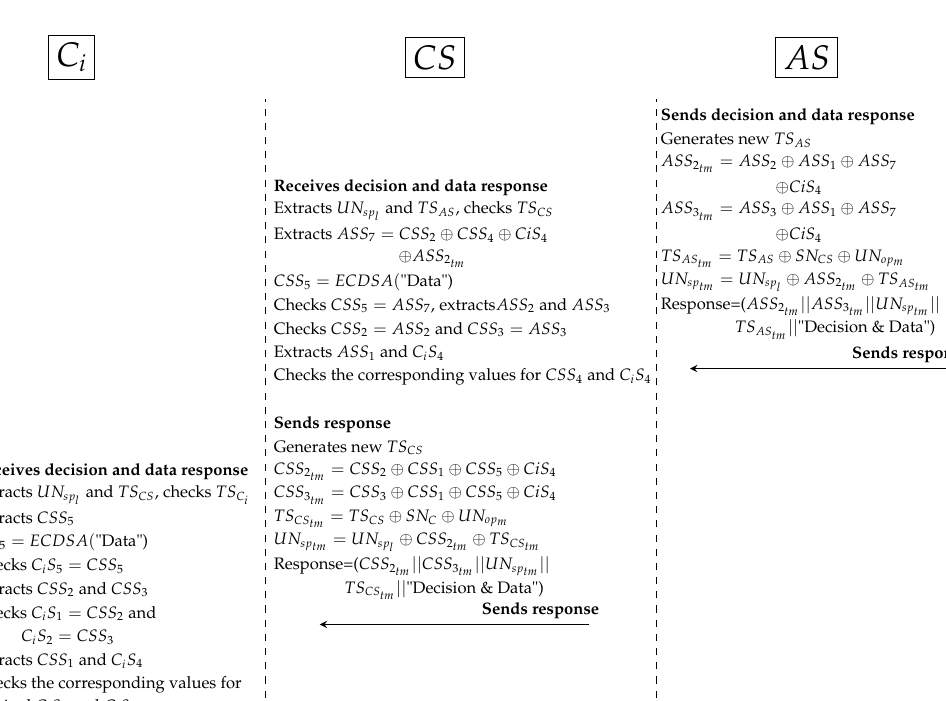
Figure 11. Protocol of PAX model between AS and DS .